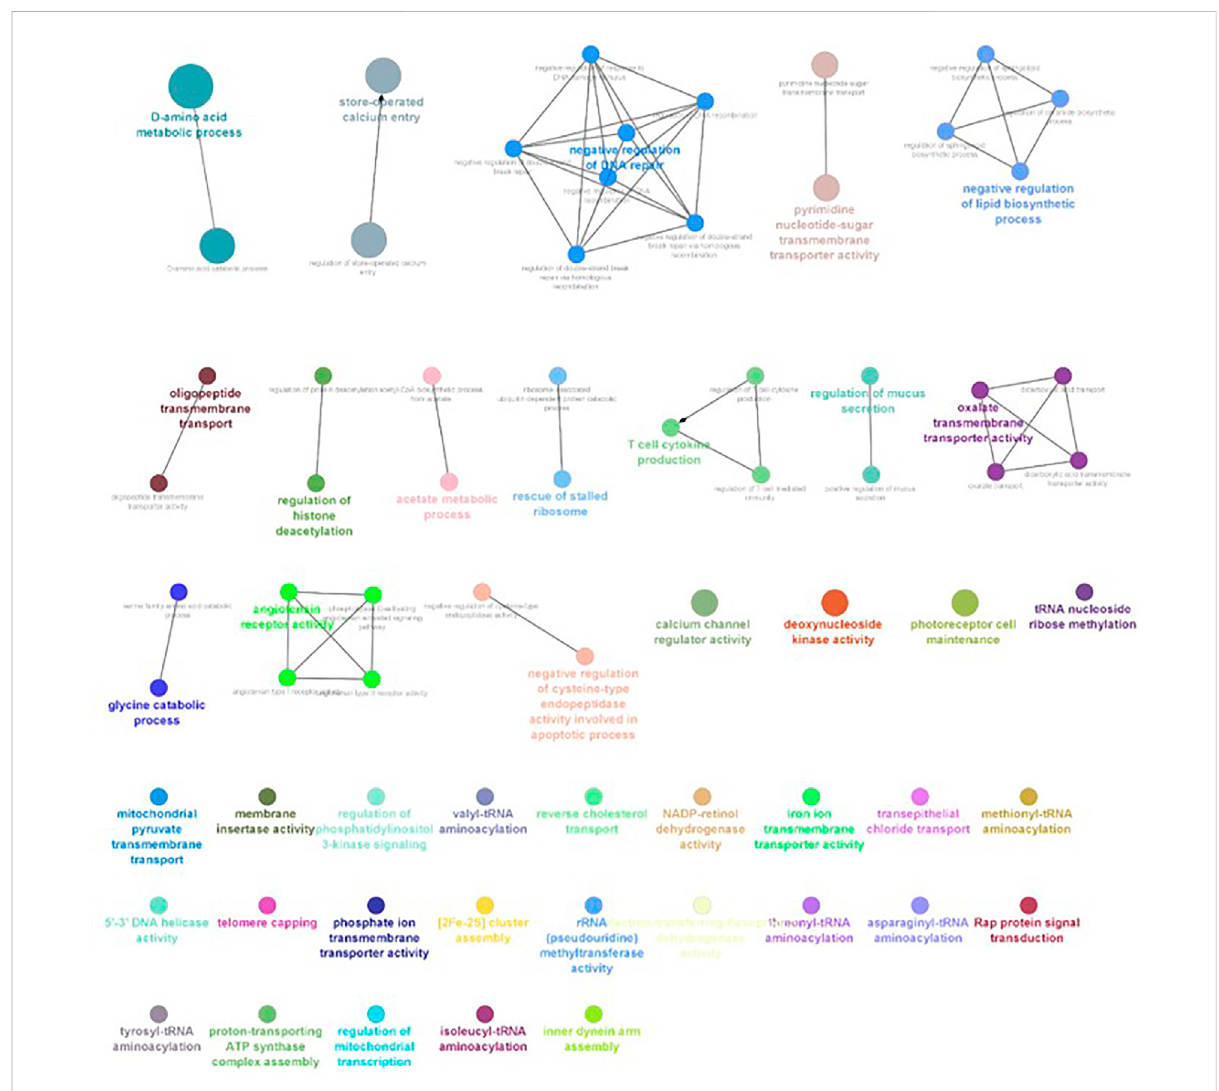
FIGURE 6 ClueGO enrichment network of the 2-ppt salinity-challenged treatment group DEGs of L. rohita , with the p -value cut-off < 0.05, the interactionsoftheGOtermnetworkdeterminedbyfunctionalnodes,andedgessharedbetweendifferentiallyexpressedgeneswithakappascoreof 0.4. The generated network has 121 nodes and 164 edges. Each node represents an individual biological process, and the color refers to the GO group. In total, 41 GO groups are presentin the network, and edges represent the relationshipbetweenthe GO termsbased on thesimilarity of their associated genes. The bold font indicates an important GO term that de fi nes the name of the biological process of each